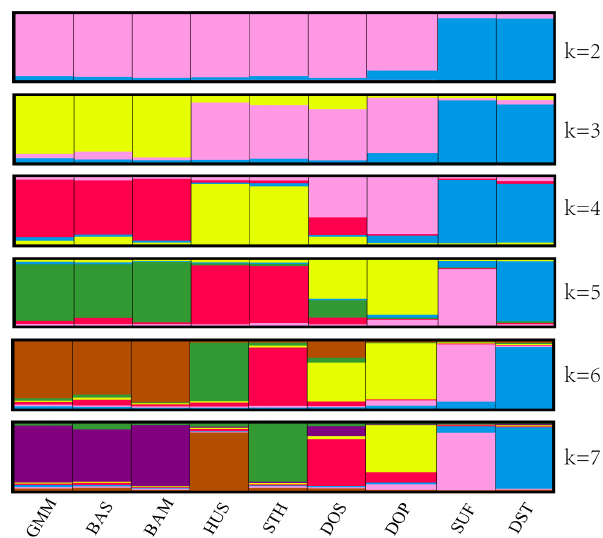
Figure 3. Population structure of nine sheep populations using model-based clustering